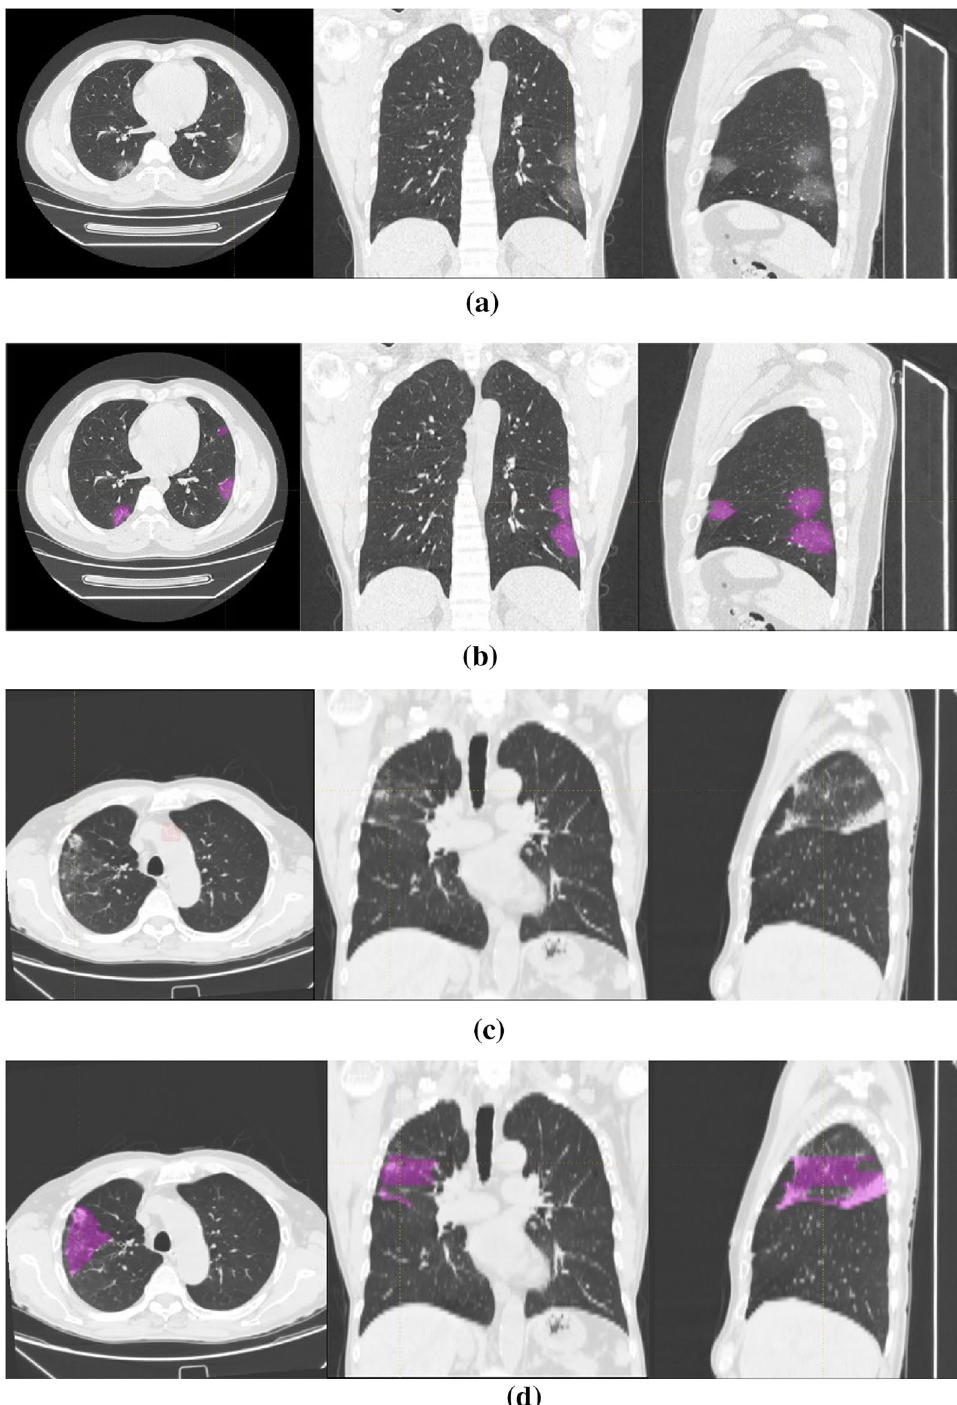
Figure 2. Image examples in different patient groups. From top to bottom: ( a , b ) a 35-year-old male with COVID-19 and COVID-19 lesion labeling (multiple ground-glass opacity, GGO); ( c , d ) a 77-year-old male with other pneumonia and other pneumonia lesion labeling (multiple patches and cloud